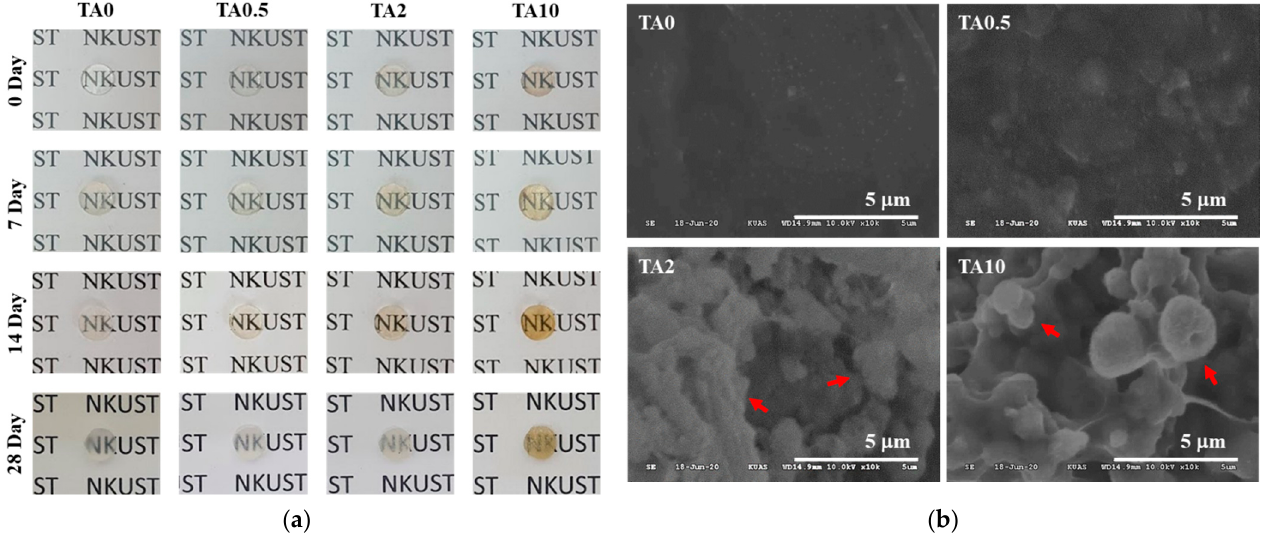
Figure 5. ( a ) Photographs of the TA-supplemented nanocomposite hydrogels before and after mineralization in HBSS. ( b ) SEM images of the surface of the hydrogels following 28 days of mineralization. The bone-like spheroidal precipitates were observed in TA2 and TA10 hydrogels (red arrows). The scale bar represents 5 μ m. Table 1. EDX analysis of the hydrogels after 28 days of mineralization.